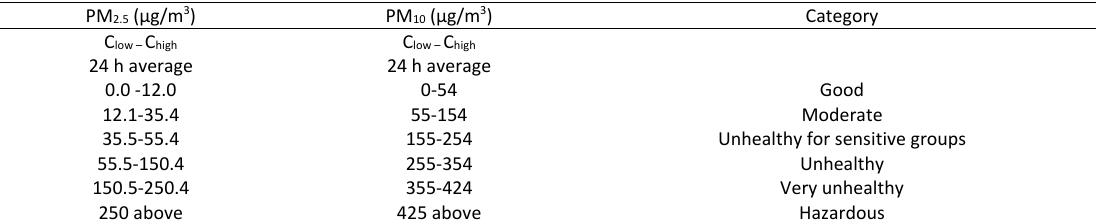
Fig. 2: PM and PM levels in µg/m 3 for the experimental study using HT-9600 2.5 10 Fig. 2: PM 2.5 and PM 10 levels in µg/m 3 for the experimental study using HT-9600 Table 3: PM 2.5 and PM 10 in µg/m 3 mapping with AQI categories (Cardinal, 2018) Table 3: PM and PM in µg/m 3 mapping with AQI categories (Cardinal, 2018 2.5 10